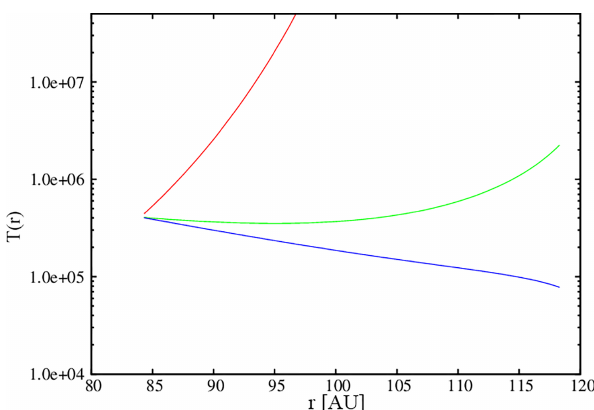
Figure 4. The κ temperature derived from Eq. (9) of Fahr et al. (2016) using the results shown in Fig. 3